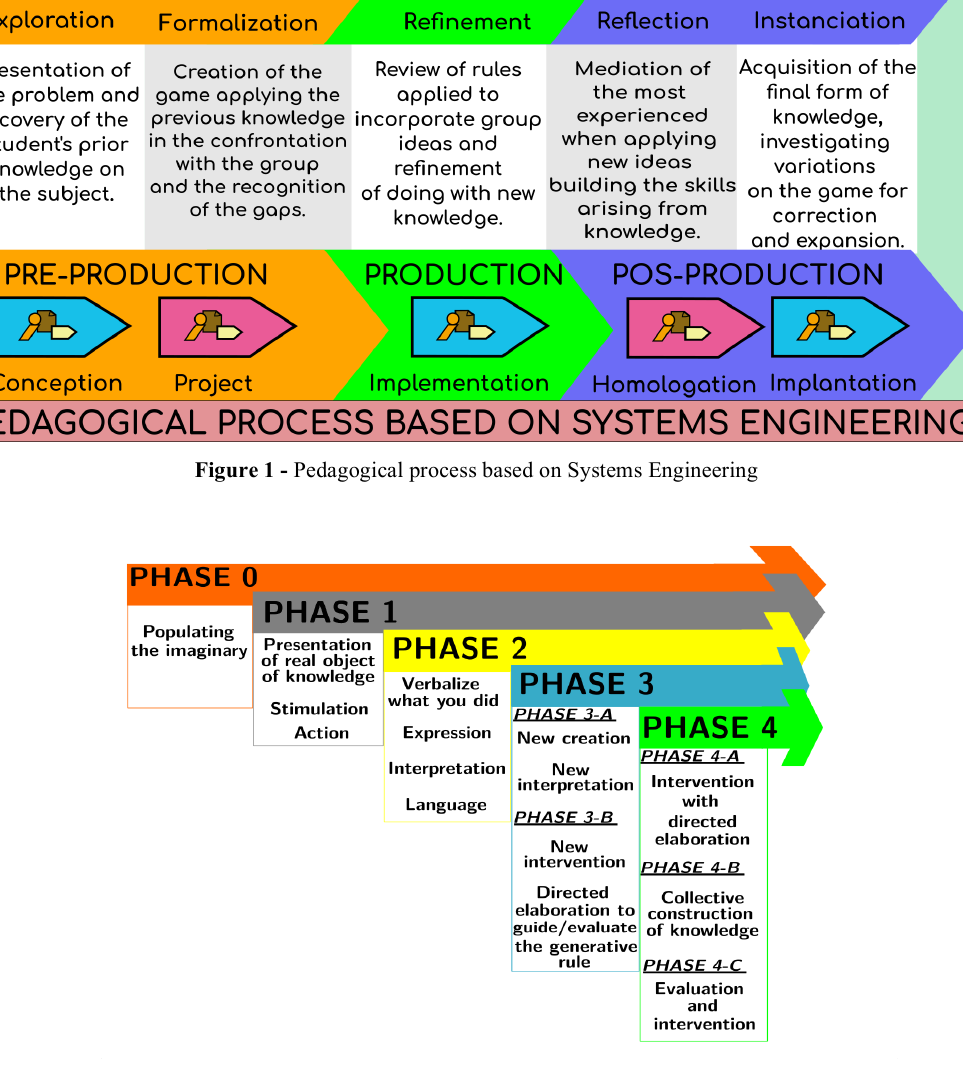
Figure 2 - Phases of Neuropedagogical Thread (Rodrigues,